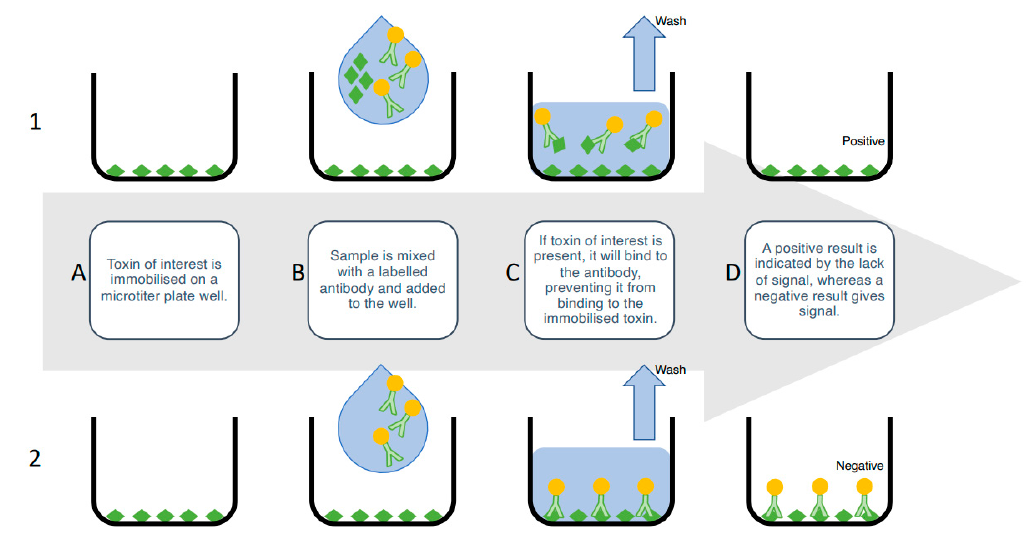
Figure 3. Inhibition-based competitive enzyme-linked immunosorbent assay. ( A ) The toxin of interest is immobilized in the solid phase on a microtiter plate well. ( B ) Sample is mixed with a labelled antibody and added to the well. ( C1 ) If the toxin of interest is present in the sample, it will compete with the immobilized toxin to bind to the labelled antibody. ( C2 ) If the toxin of interest is not present, the labelled antibody will bind to the immobilized toxin. ( D ) Unbound antibody is washed out and the wells imaged. ( D1 ) A positive result is indicated by the lack of signal, because toxin in the sample has prevented the antibody from binding, whereas ( D2 ) a negative result is indicated by a signal, because the labelled antibody has not been inhibited from binding to the immobilized toxin.